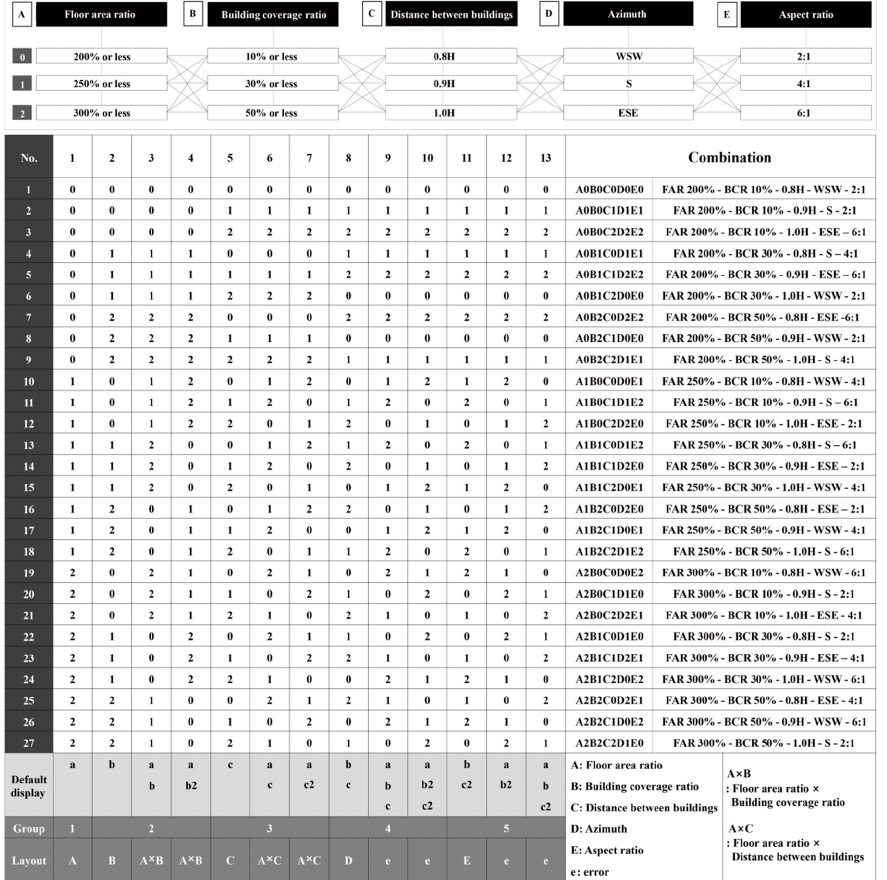
Figure 3. Case settings of the orthogonal matrix L 27 (3 13 ).